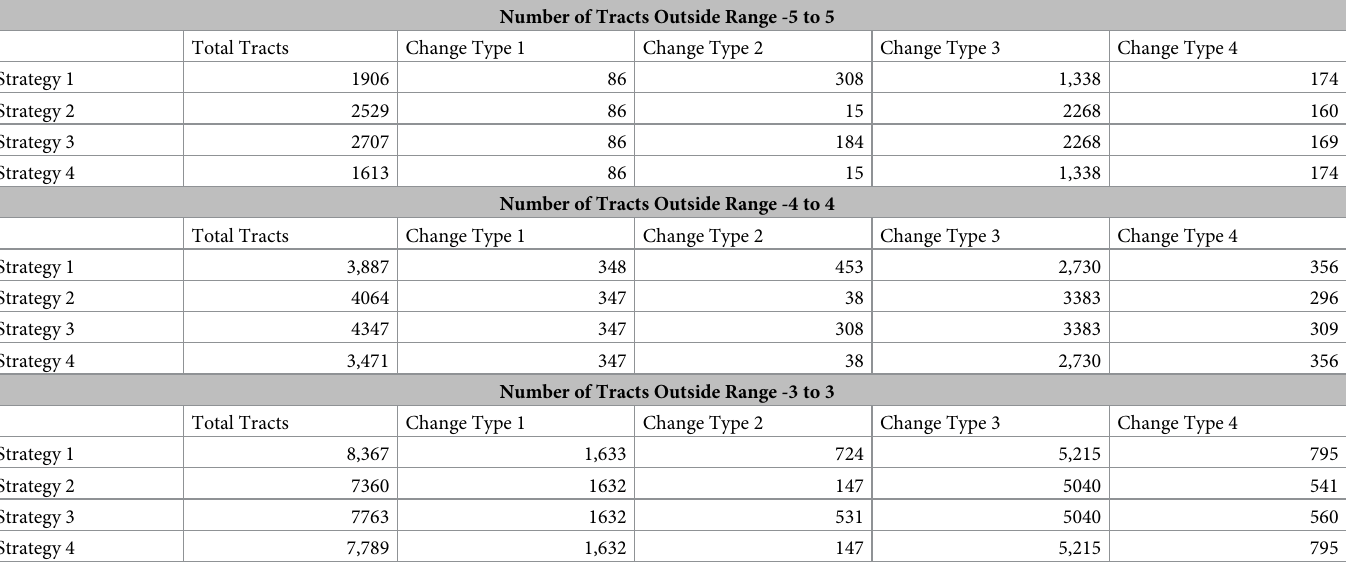
Table 3. Uncertainty assessment of the BITS.